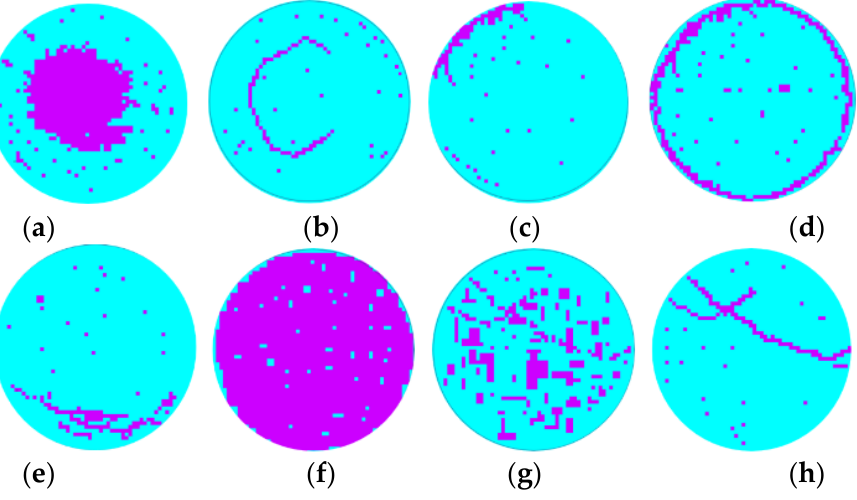
Figure 4. Eight types of wafer map defect pattern types: ( a ) center, ( b ) donut, ( c ) edge-loc, ( d ) edge-ring, ( e ) local, ( f ) near-full, ( g ) random, and ( h ) scratch.